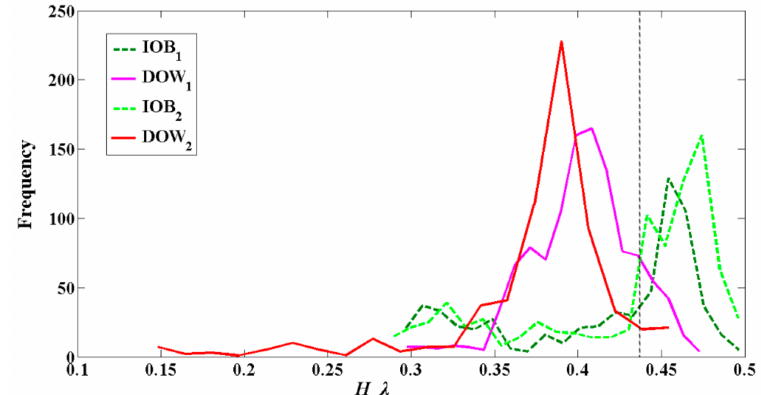
Figure 7. Comparison of histogram curves of parameter H_ λ for the samples of intact oriented buildings and damaged oriented walls. IOB 1 , DOW 1 , IOB 2 , DOW 2 represent No. 1 sample of intact oriented buildings, No. 1 sample of damaged oriented walls, No. 2 sample of intact oriented buildings and No. 2 sample of damaged oriented walls, respectively. The location of the black dotted line denotes the threshold value for separating the intact oriented buildings and the damaged oriented walls.